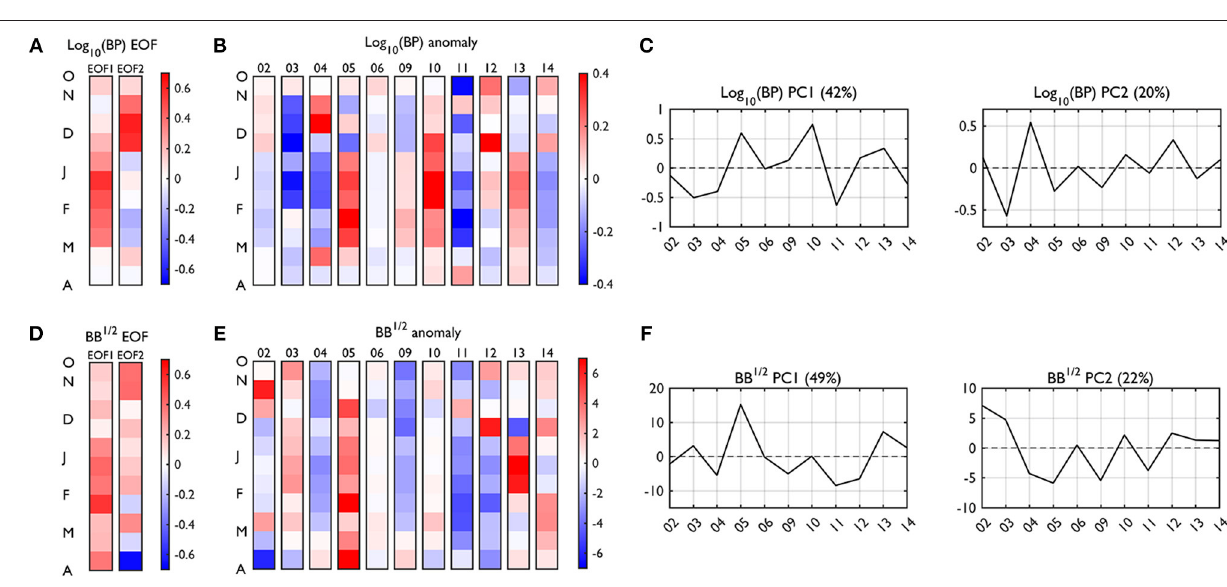
FIGURE 8 | Empirical orthogonal function (EOF) and anomaly plots of depth-integrated BP and BB. The EOF (A,D) patterns and RSOA-interpolated anomaly plots (B,E) reconstructed using the first 4 and 5 dominant EOF modes, accounting for 86.6 and 97.9% of total BP and BB variability, respectively. The percentages captured by each EOF mode are presented in the corresponding principal component (PC) time series (C,F) , which indicates interannual variability of the seasonal patterns detected by the corresponding EOF. The red colors represent positive anomalies, and blue colors represent negative anomalies relative to